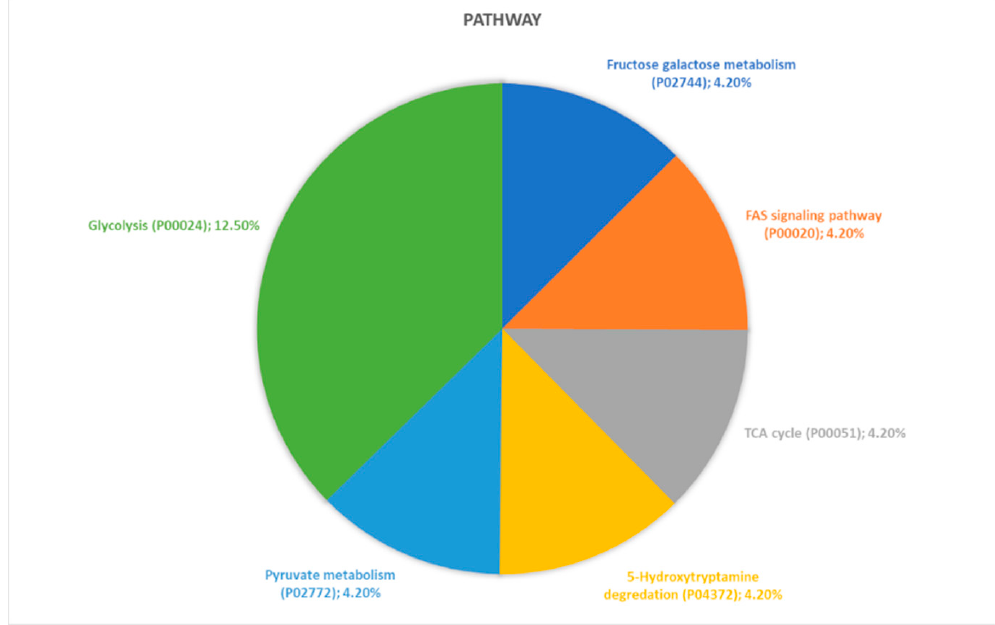
Figure 5. PANTHER classification of differently regulated proteins in RAOM in according to their pathway classification.